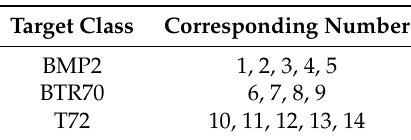
Figure 13. Experiment on complex background image ( a ) target distribution; ( b ) interpretation results. Table 3. Number of chosen images.